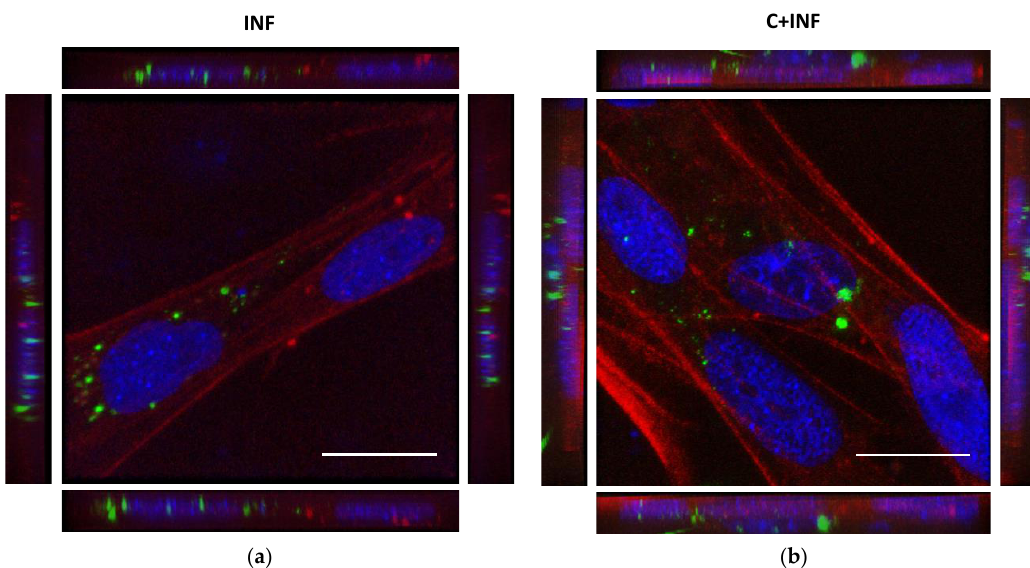
Figure 1. Intracellular location of P. salmonis between rainbow trout myotubes infection and cortisol pretreatment. Representative confocal images of the immunofluorescence staining of P. salmonis (green) and phalloidin (actin cytoskeleton, red). ( a ) Primary culture of rainbow trout skeletal muscle cells infected with P. salmonis strain LF-89 (MOI 50) for 8 h (INF). ( b ) Rainbow trout myotubes pretreated with 3 h of cortisol (100 ng/mL) followed by infection with P. salmonis (C+INF). Nuclei were stained with DAPI (blue). The images represent a maximum projection for the total nuclear volume. Scale bar: 20 µm.